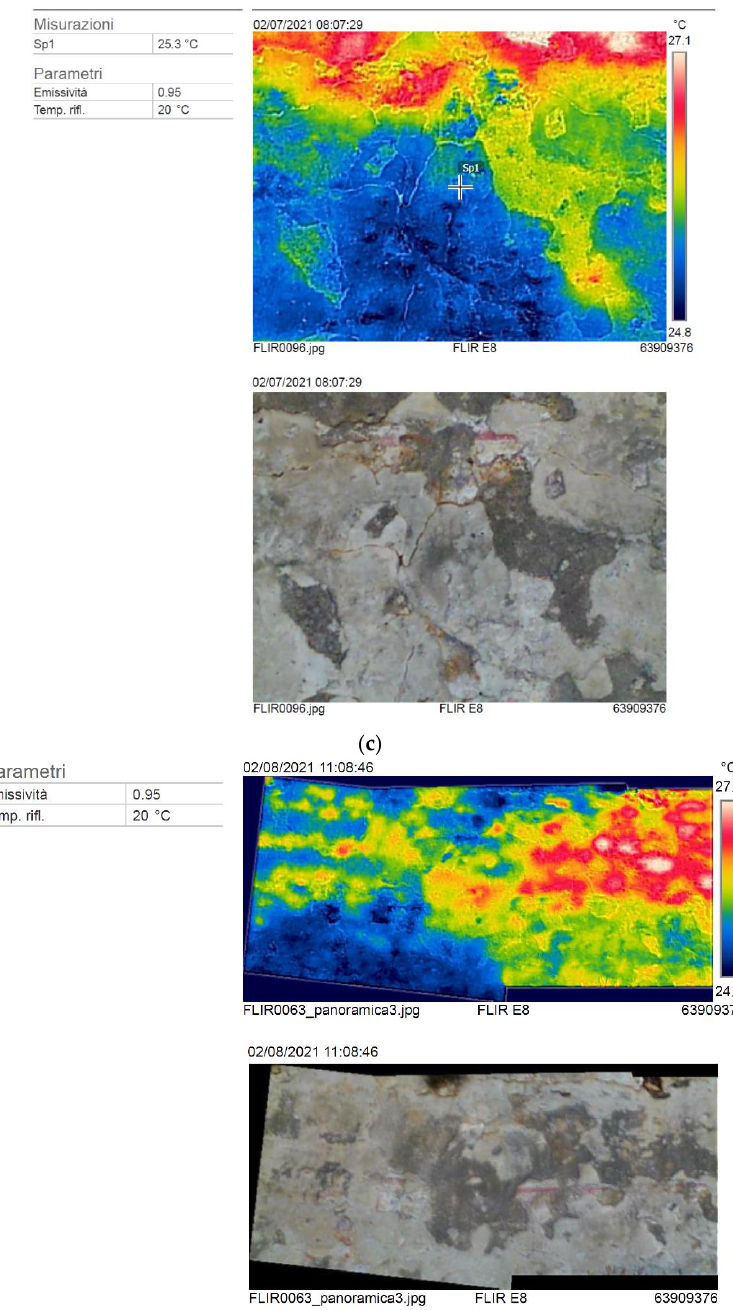
Figure 25. IR thermal images of single portions ( a – c ) and photomosaic ( d ).